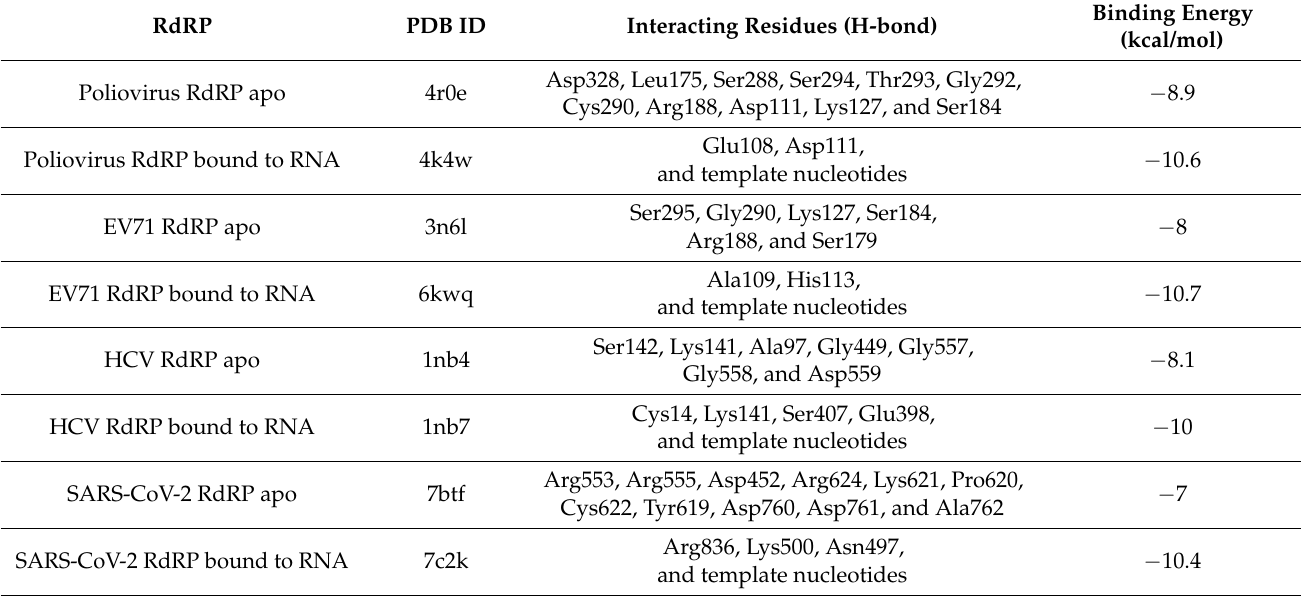
Table 3. NADPH docked against different viral RdRPs in their apo and template-bound conforma-